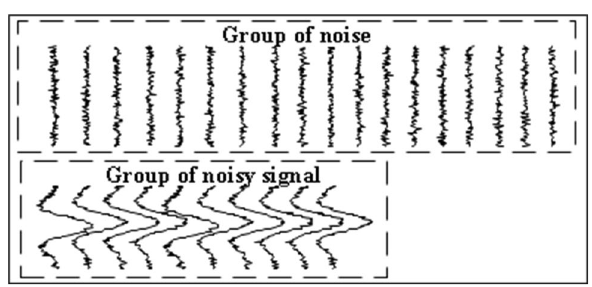
Fig. 4 Diagram of group